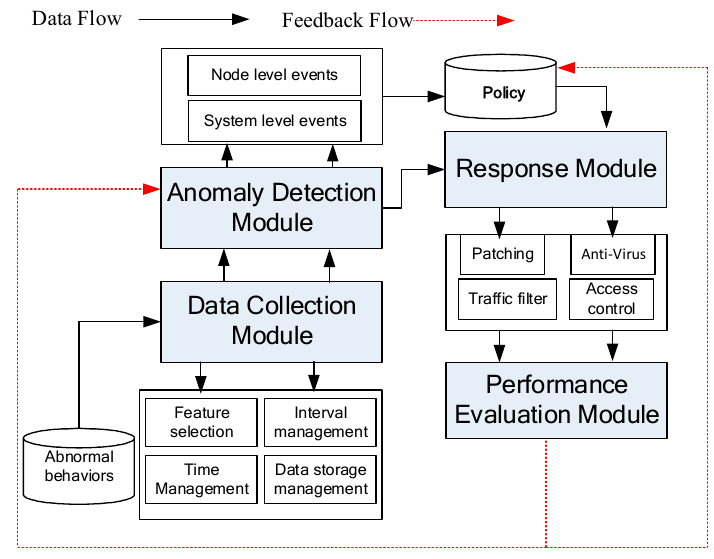
Figure 2. Operation procedure of IMLADS.